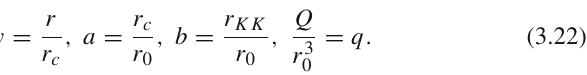
Fig. 3 The relation of V tot ( x ) and q in the D(-1)–D3 background with b = 0 . 5 , ˜ α =